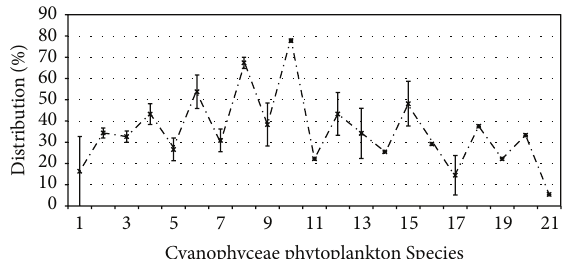
Figure 8: Overall mean values of Cyanophyceae species in Okpoka Creek. (1 = A. sp , 2 = A. affinis , 3 = A. arnoldii , 4 = A. spiroides , 5 = A. arnoldii , 6 = S. subsalsa , 7 = S. laxissima , 8 = S. major , 9 = S. princeps , 10 = M. pulverea , 11 = O. princeps , 12 = O. lacustris , 13 = O. tenuis , 14 = O. sp , 15 = R. sp , 16 = L. hieronymussi , 17 = L. limnetica , 18 = L. major , 19 = R. curvata , 20 = P. musicola , and 21 = N. sp ).